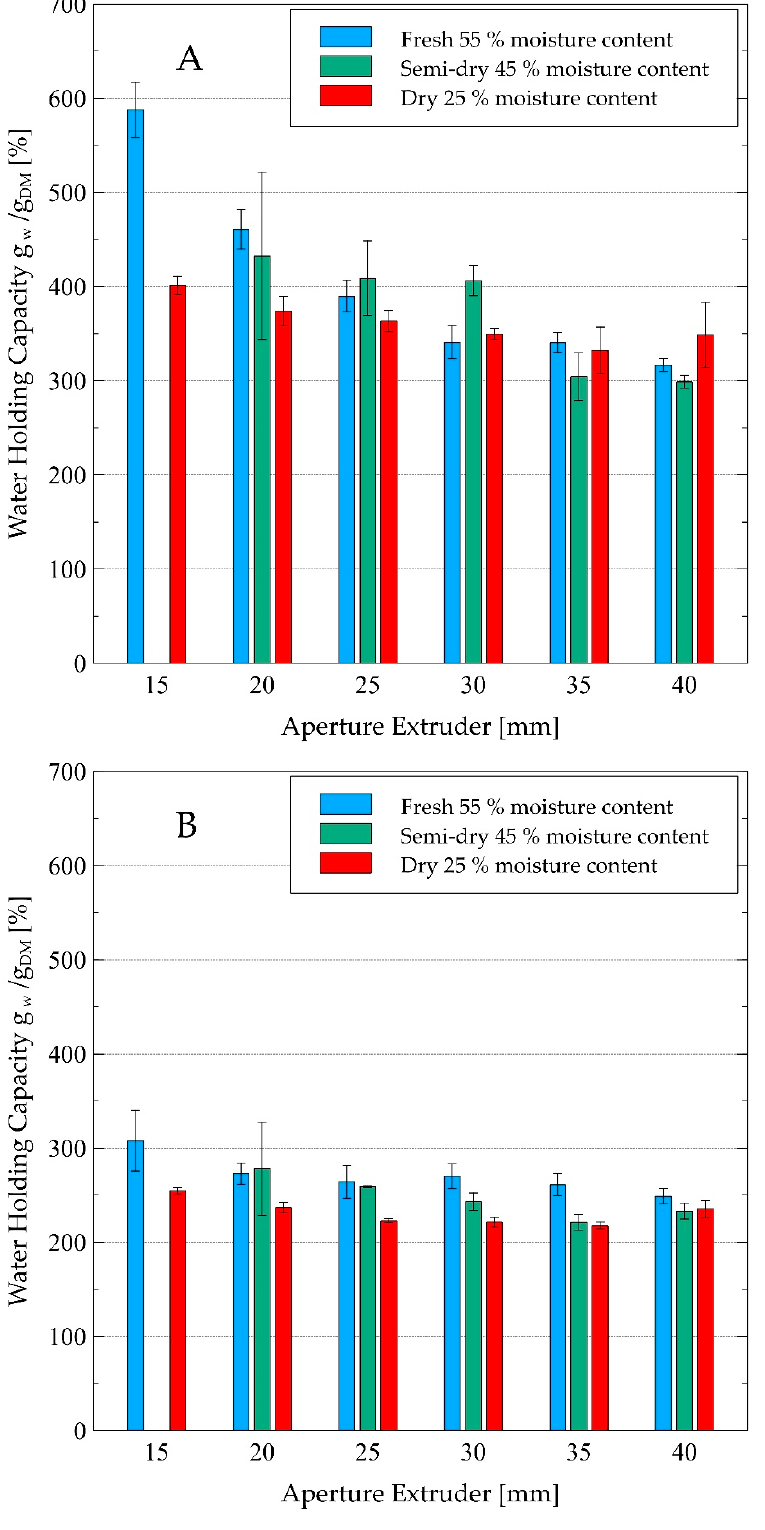
Figure 3. Dry matter-based WHC of − 1 kPa ( A ) and − 5 kPa ( B ). Comparison of fresh, semi-dry, and dry extruded poplar.